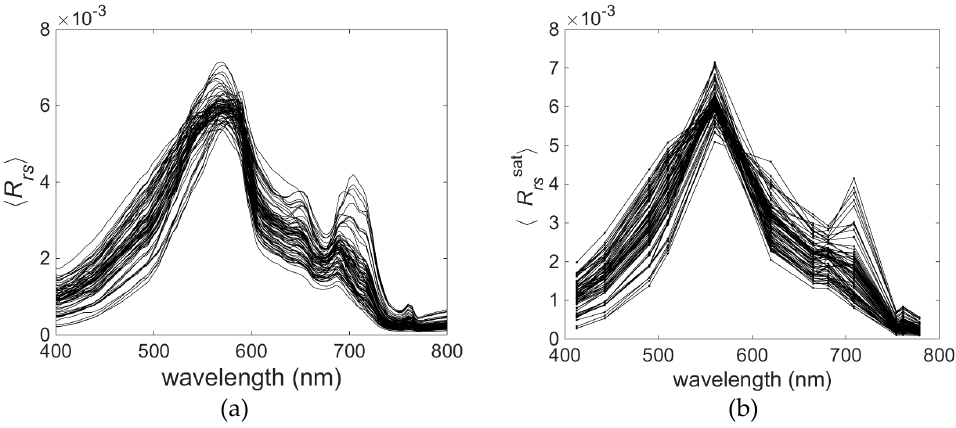
Figure 5. Variability in the spectral shape of remote sensing reflectance R rs ( λ ) measured in the Gulf of Gdansk ( a ). The synthetic MERIS/OLCI reflectance based on the measured R rs ( λ ) spectra with reduced spectral resolution. Dots show the waveband centres of the MERIS/OLCI radiometer between 400 nm and 800 nm ( b ).